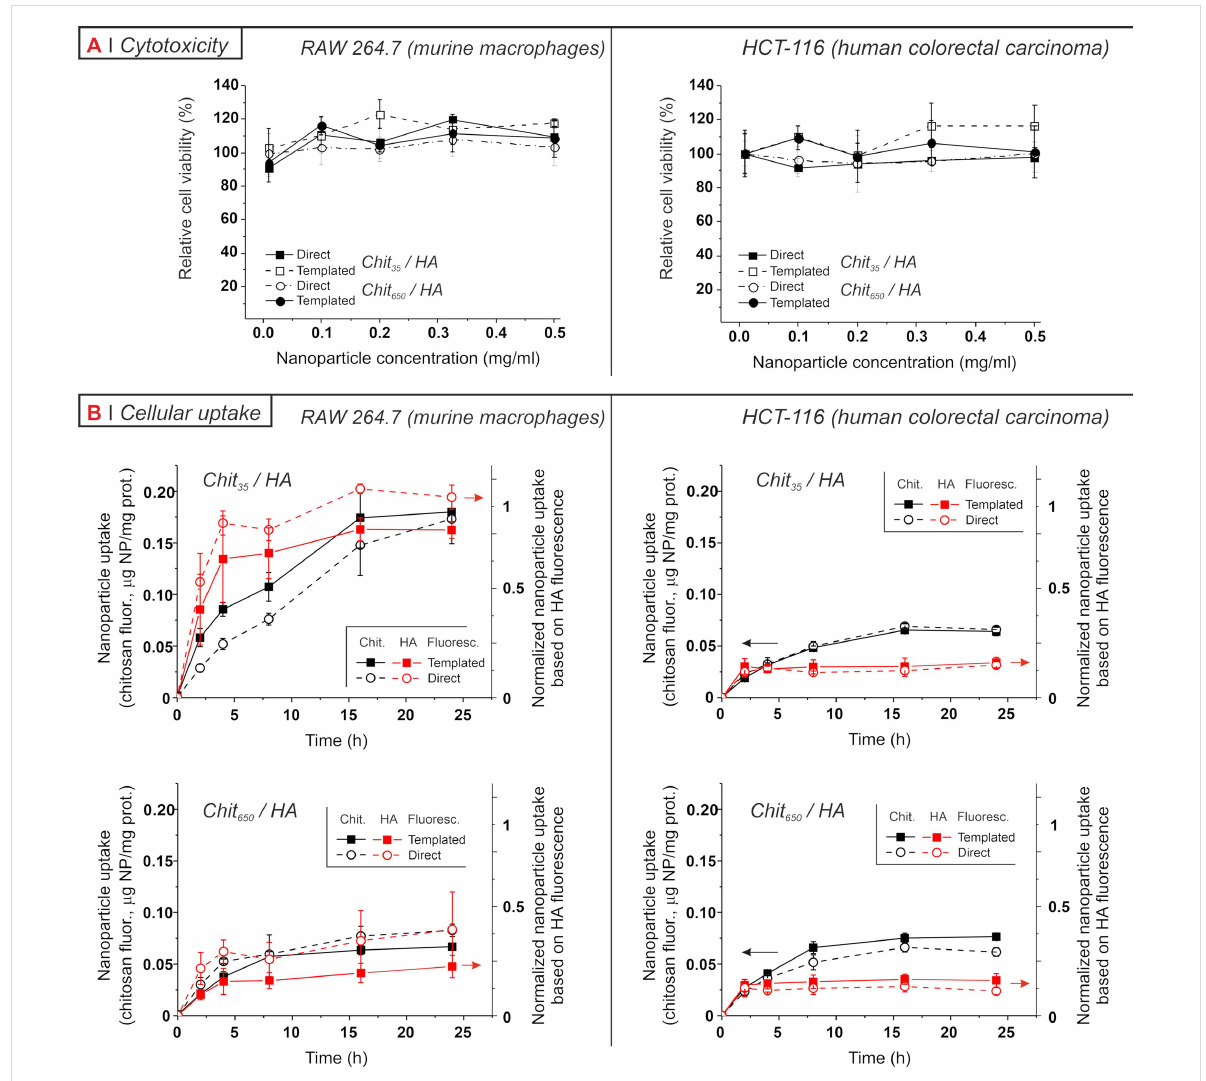
Figure 5: A) Relative cell viability of RAW 264.7 (left) and HCT-116 (right) cell lines as a function of nanoparticle concentrations (0.01–0.5 mg/mL, 24 h incubation). Percentages are relative to the normalized mitochondrial activity of untreated cells. The differences between preparative methods are not statistically significant. B) The cellular uptake of nanoparticles was followed by measuring the fluorescence of lysates after cells were incubat- ed with particles containing RITC-labelled chitosan or rhodamine-labelled HA. The lysate fluorescence is a quantitative measure of the nanoparticle uptake (bound and internalized particles), and the data are first calibrated with nanoparticles dispersed in cell lysates to obtain quantities of nanoparti- cles and then normalized against the cell protein content to finally obtain values of the amount of nanoparticles uptaken “per cell”. It is noteworthy that for any given data point the uptake measured from HA-associated fluorescence was consistently lower than that obtained via chitosan fluorescence. Since the fluorophores are essentially the same, this may be due to a detachment of the two components upon uptake, because the quantum yield of the fluorophores in isolated chitosan or HA and in nanoparticles may be significantly different. For comparison, we have therefore further normalized the data from HA fluorescence to the average value of Chit 35 /HA nanoparticles in RAW macrophages after 24 h. In all graphs, error bars represent standard deviation ( n =